Question: Name the type of graph shown.
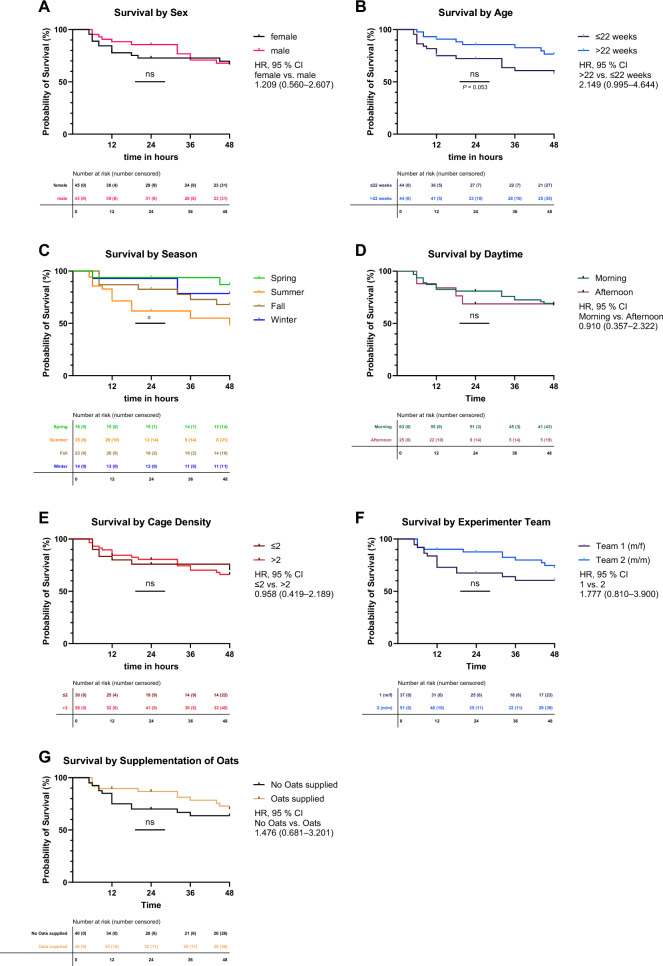
Answer: survival